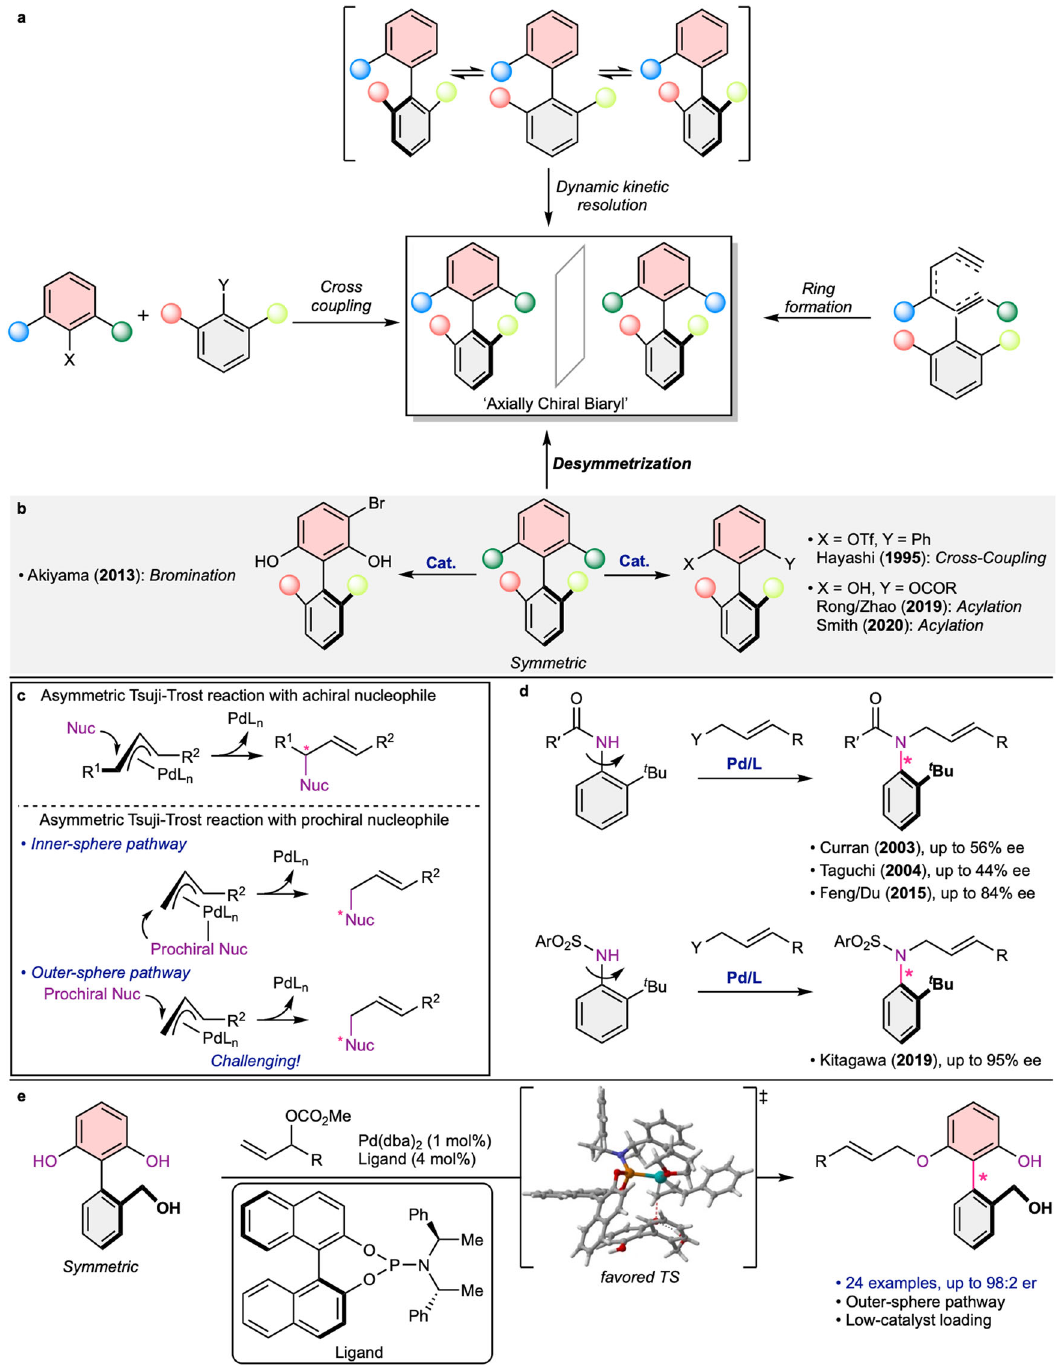
Fig. 1 Strategies on the asymmetric synthesis of axially chiral biaryls and the catalytic asymmetric Tsuji-Trost reactions. a Strategies on the asymmetric synthesis of axially chiral biaryls. b Representative examples for atroposelective desymmetrization of biaryls. c Catalytic asymmetric Tsuji- Trost reactions. d Atroposelective allylations of anilides by dynamic kinetic resolution. e Palladium-catalyzed atroposelective desymmetric allylation (this